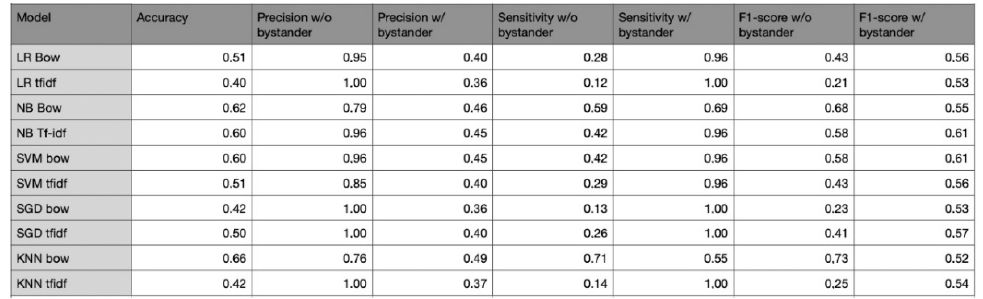
Figure 20. Simple model metrics applied to full descriptions.